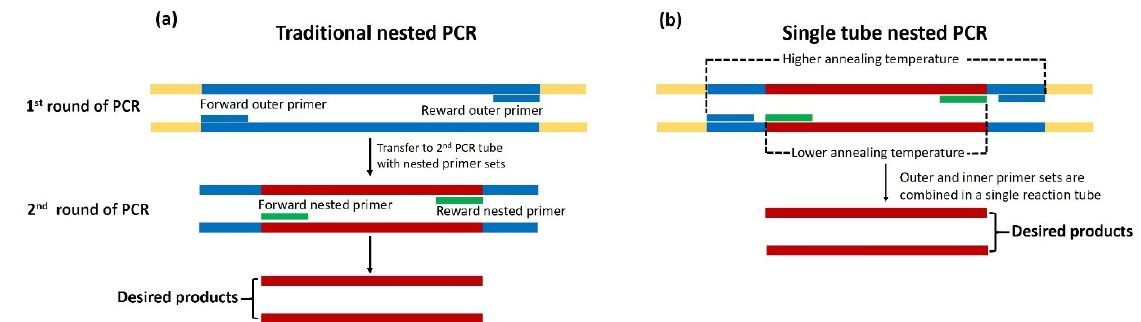
Figure 5. Schematic diagram of traditional and single ‐ tube, nested PCR assays for detecting P. insidiosum . ( a ) The traditional nested PCR method requires two rounds of PCR amplification. The first ‐ round reaction amplifies a target sequence using the first or outer primer pair (short blue lines). The amplicon from the first ‐ round PCR serves as a template of the second or outer primer pair (short green lines) for amplifying the P. insidiosum ‐ specific PCR product. ( b ) For the single ‐ tube, nested PCR, the assay combines outer (short blue lines) and inner (short green lines) primers to amplify the target sequence in one tube. The first ‐ round PCR, using the outer primers, is performed at a higher annealing temperature. In contrast, the second ‐ round PCR, using the nested primers, is sequentially conducted at a lower annealing temperature. The diagram is adapted from the references [59,60].